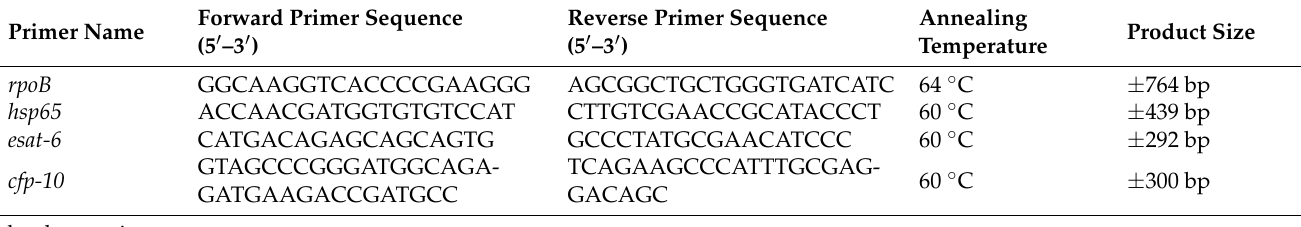
Table 1. Oligonucleotide sequences and PCR conditions for mycobacterial speciation of oronasal swab cultures from African